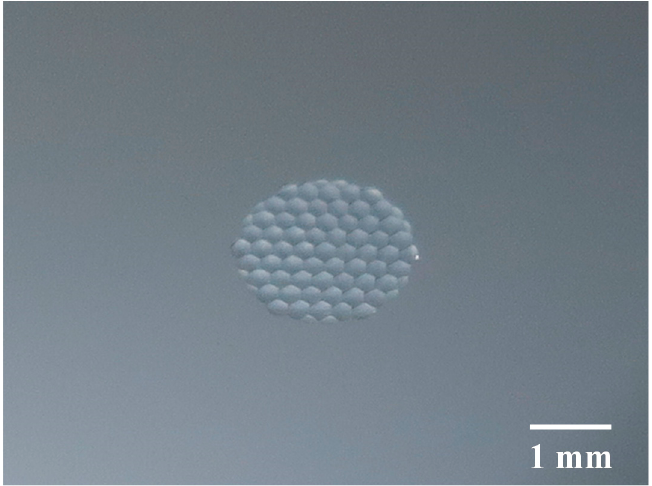
Figure 16. Photograph of a hexagonal microlens array machined on a single-crystal silicon wafer.